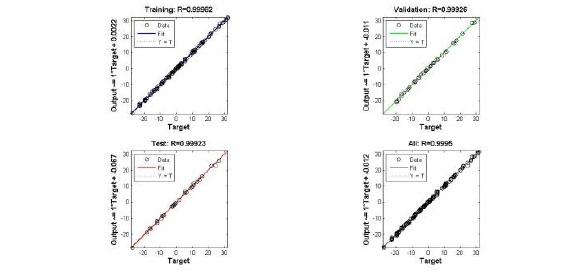
Figure 11: The training, validation, testing data, and all data plots.